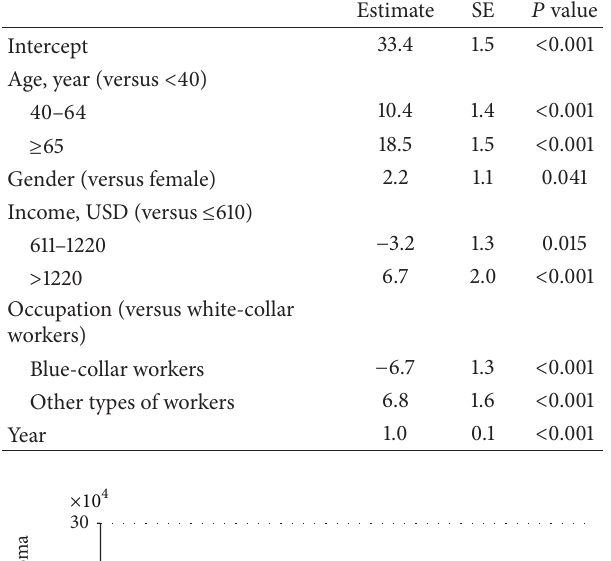
Table 2: The results of generalized estimating equations regression model (USD/year).